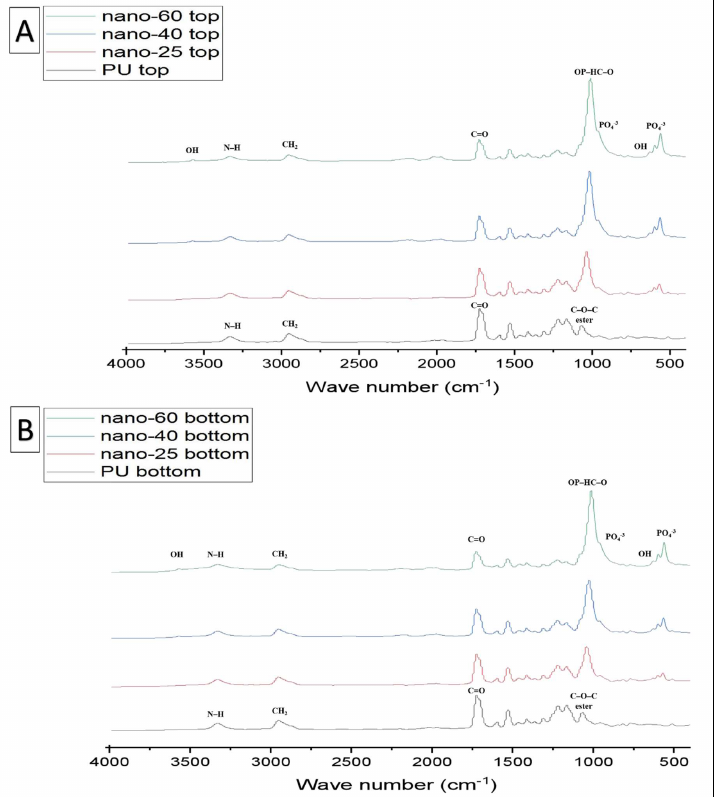
Figure 6. FTIR-ATR Spectra of different groups taking PU as a control ( A ) top surface of PU and PU/HA nano scaffolds ( B ) bottom surface of PU and PU/HA nano scaffolds.